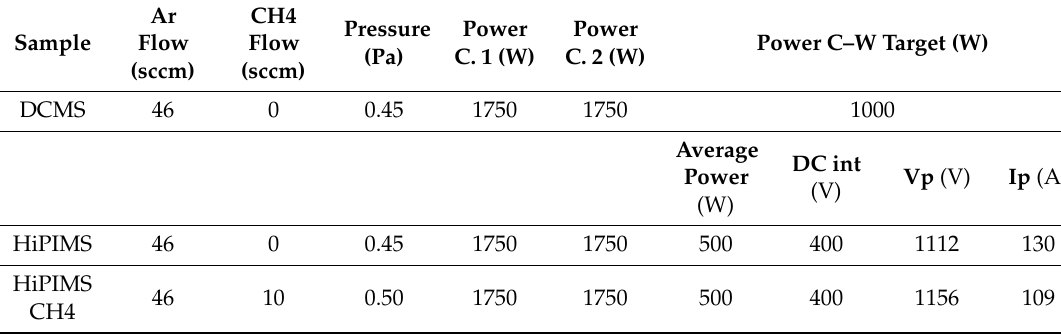
Table 1. Deposition conditions of